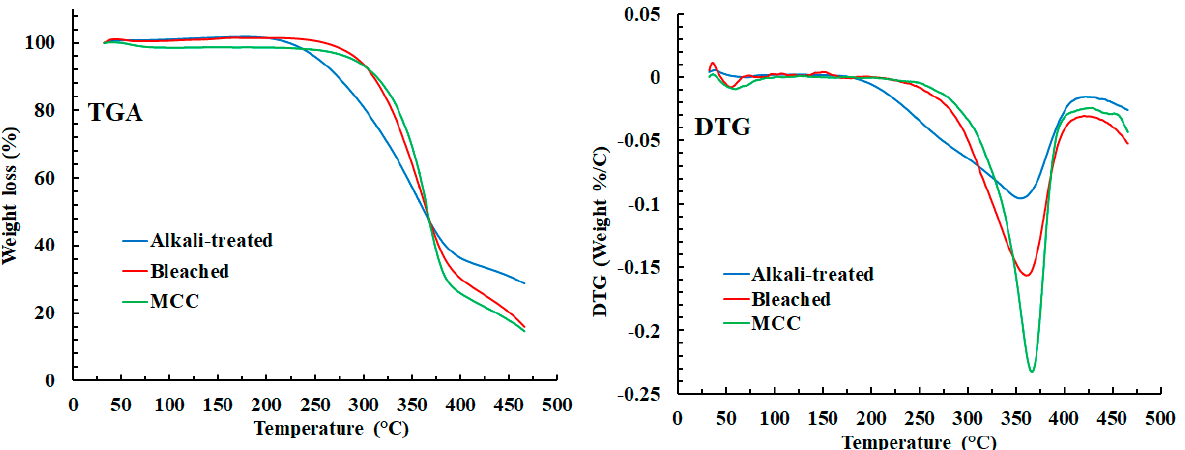
Figure 5. TG and DTG curves of alkali-treated, bleached, and MCC samples, indicating that higher thermal stability ( T max ) is exhibited by acid-hydrolyzed MCC than alkali-treated and bleached pedicle fibers.